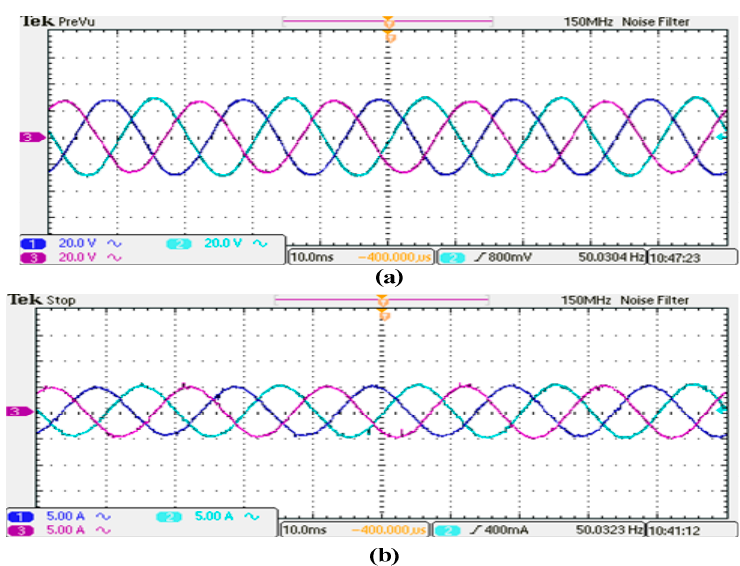
Figure 25. DFIG system in weak grid with low bandwidth SRF-PLL ( a ) Stator voltage, and ( b ) Stator current.